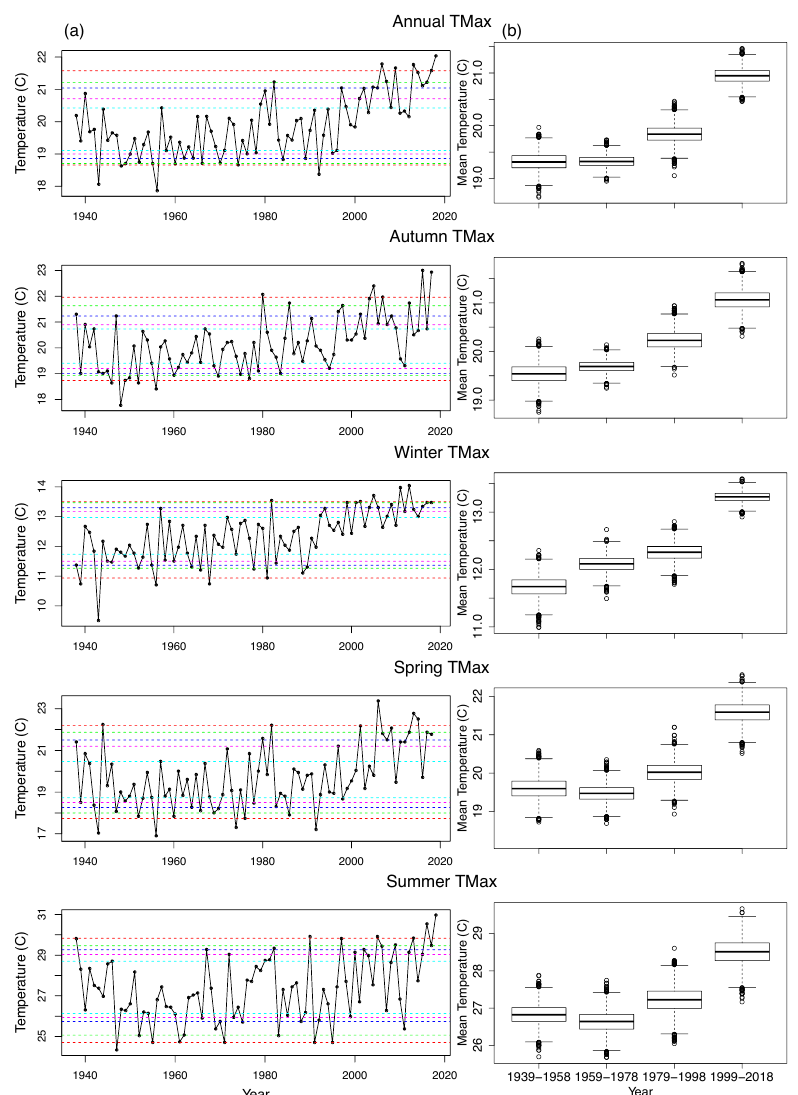
Figure 4. ( a ) Time series and ( b ) box plots as in Figure 3 except for